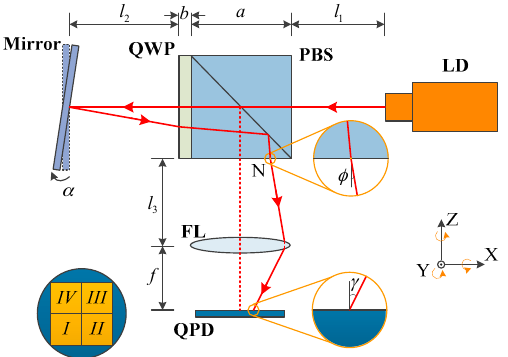
Figure 2. Diagram and parameters of the angle sensor.